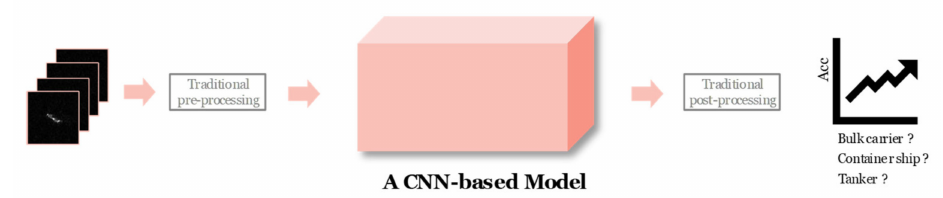
Figure 2. Diagrammatic sketch of traditional pre-processing and